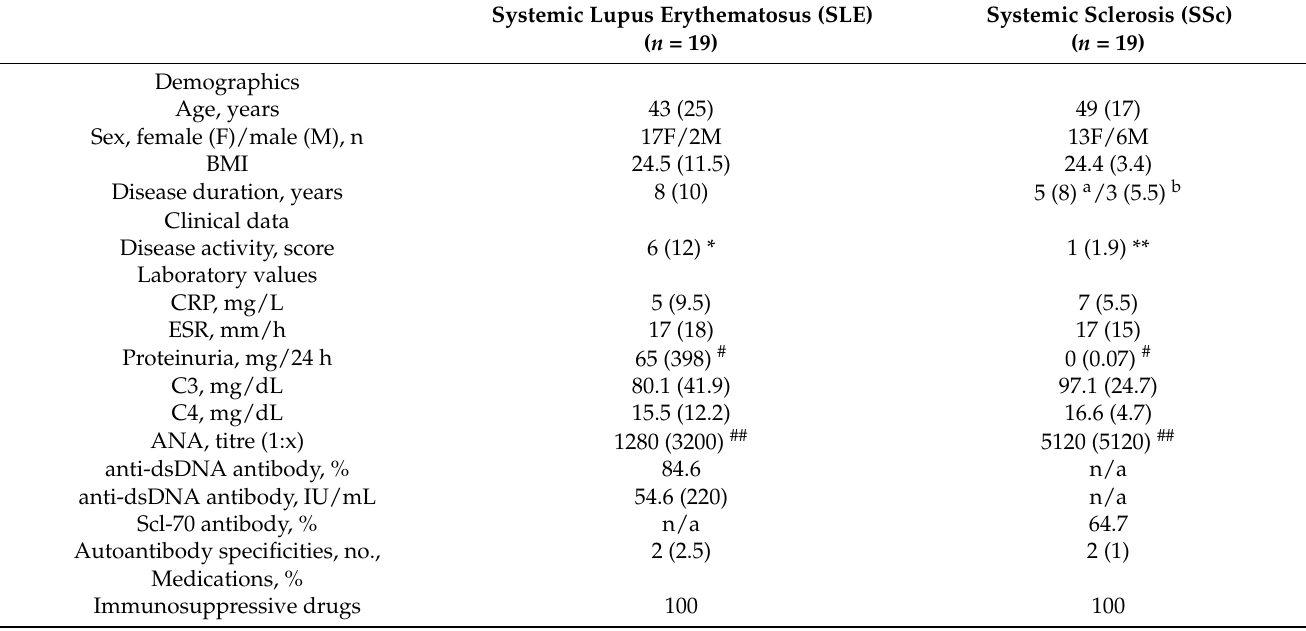
Table 1. Demographic and clinical characteristics of the patients. Systemic Lupus Erythematosus (SLE) ( n = 19)